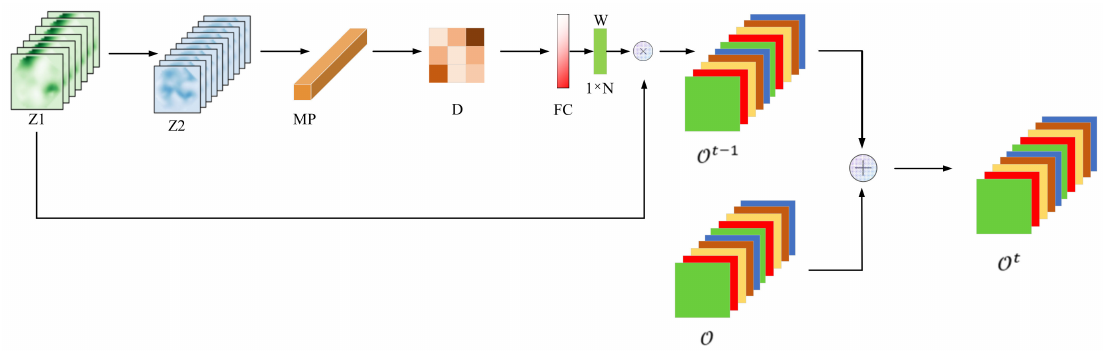
Figure 3. The details of discrimination learning